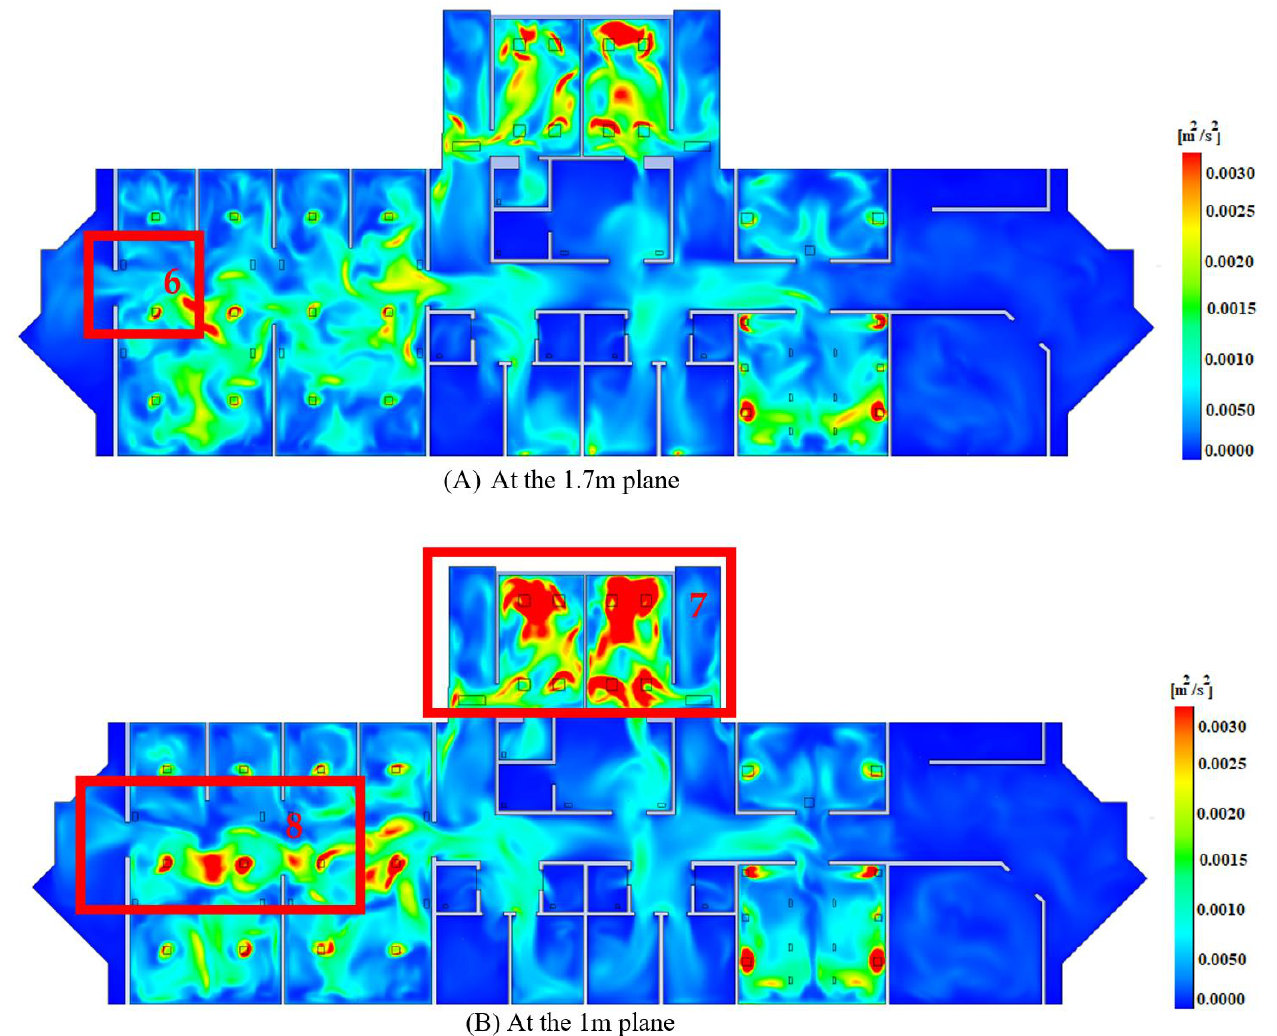
Figure 7. Turbulence kinetic energy profiles.